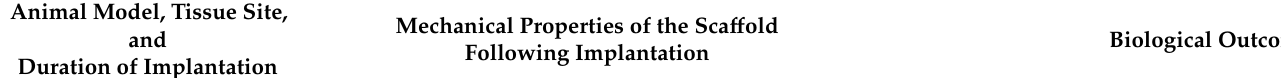
Table 3. In vivo performance of bio-hybrids constructs in tendon tissue engineering ( ↑ = increase; ↓ =